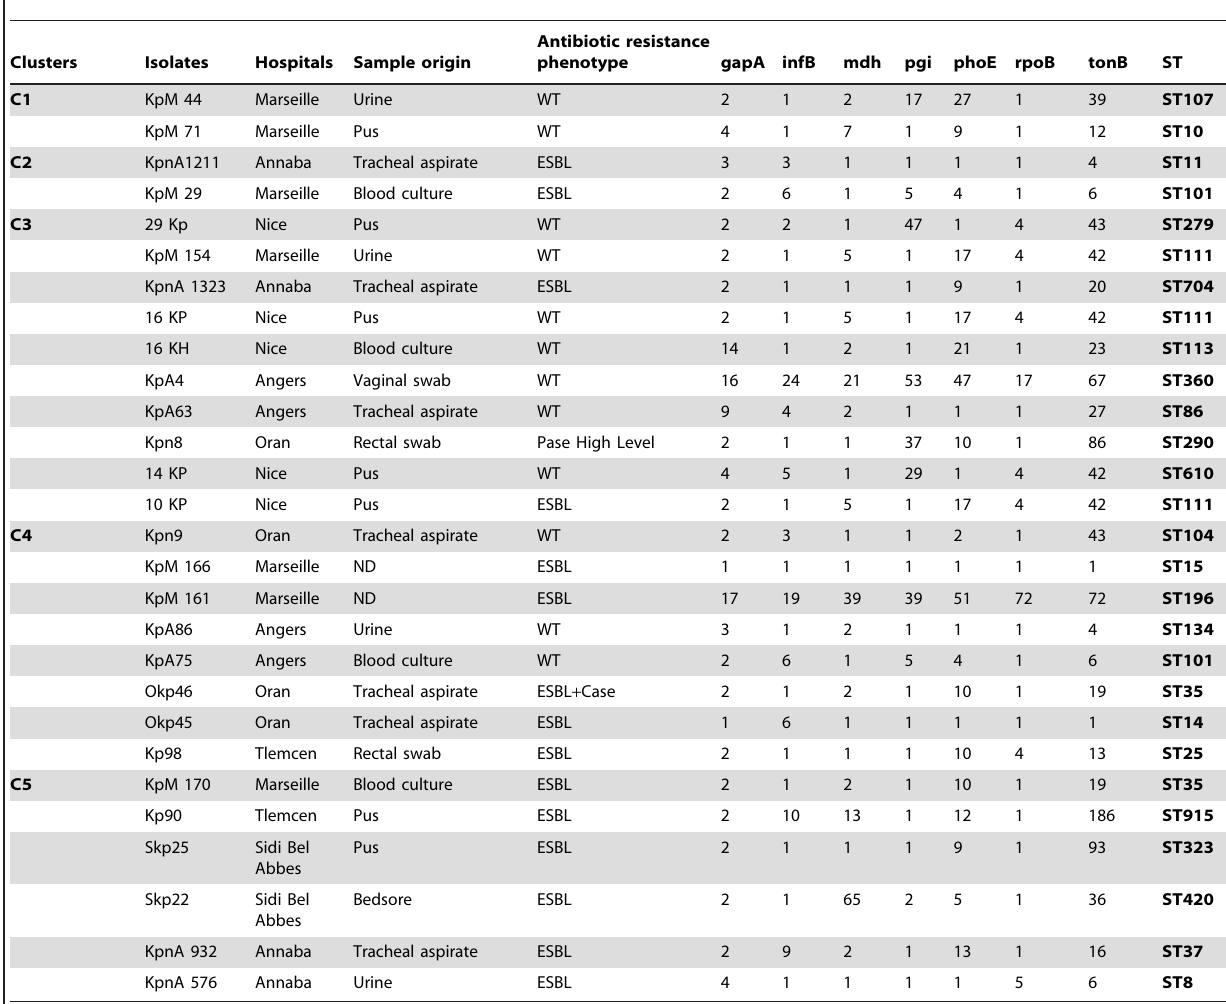
Table 5. MLST allelic profile of Klebsiella pneumoniae clinical isolates distributed in the five clusters.